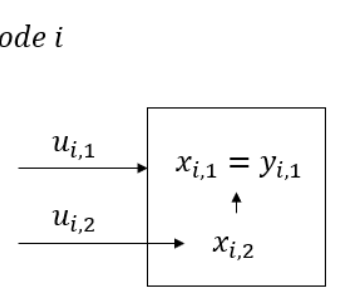
Figure 5. Diagram and variables of the nodes of the network defined in the use case. The application of the centralised MPC to the specific use case is graphically syn- thetised in Figure 6.